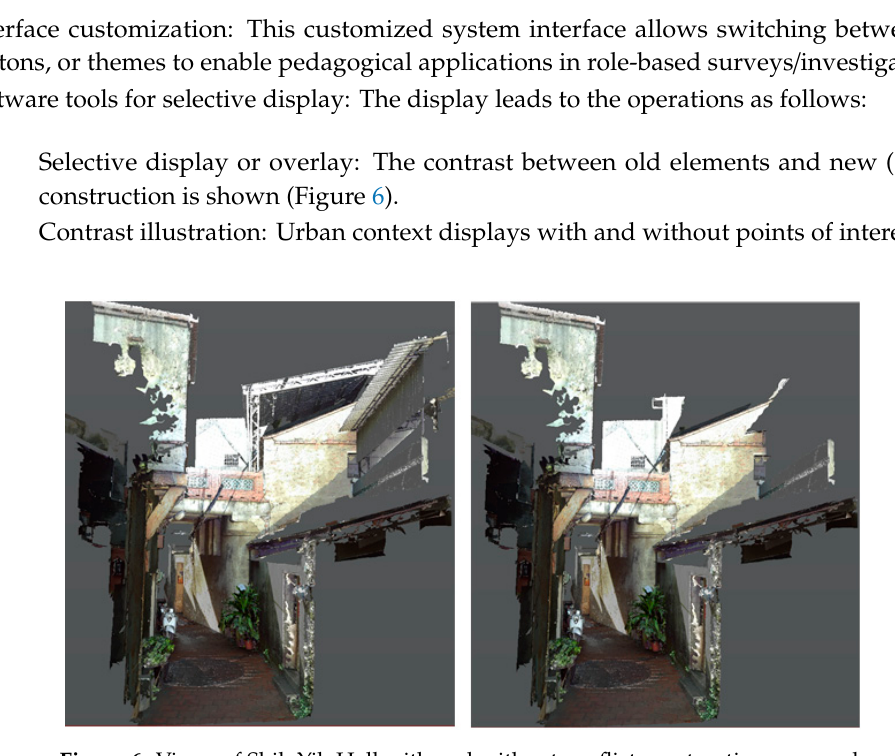
Figure 5. Superimpositions of section annotations (in red line) for an alley in Lukang.